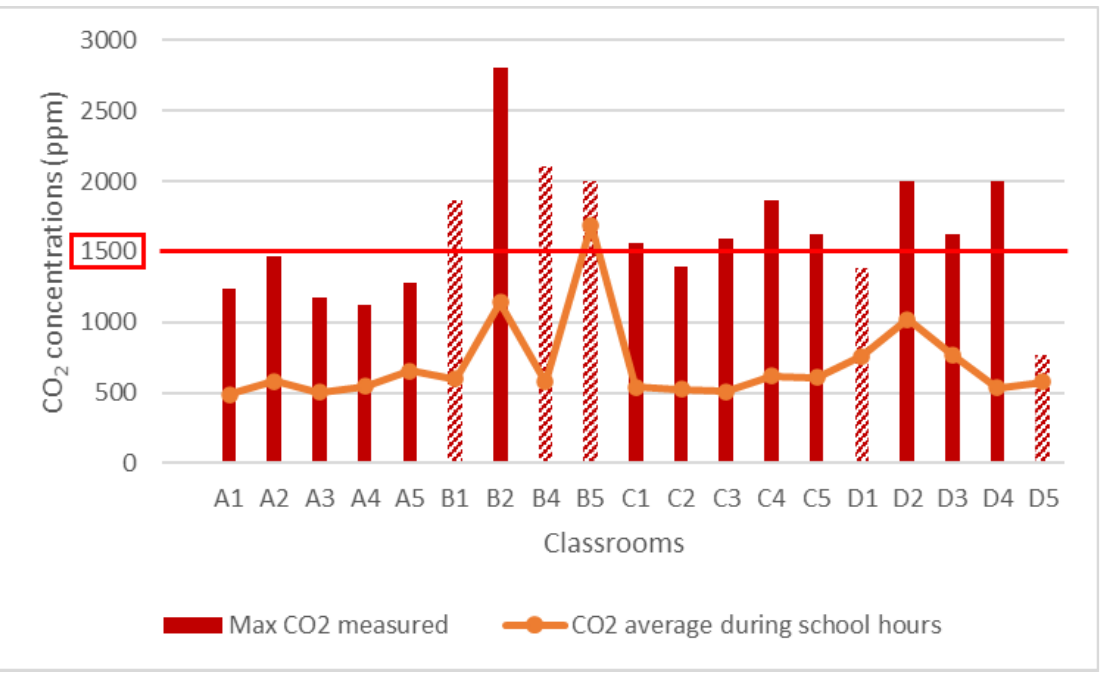
Figure 23. CO 2 concentrations in the classrooms during school